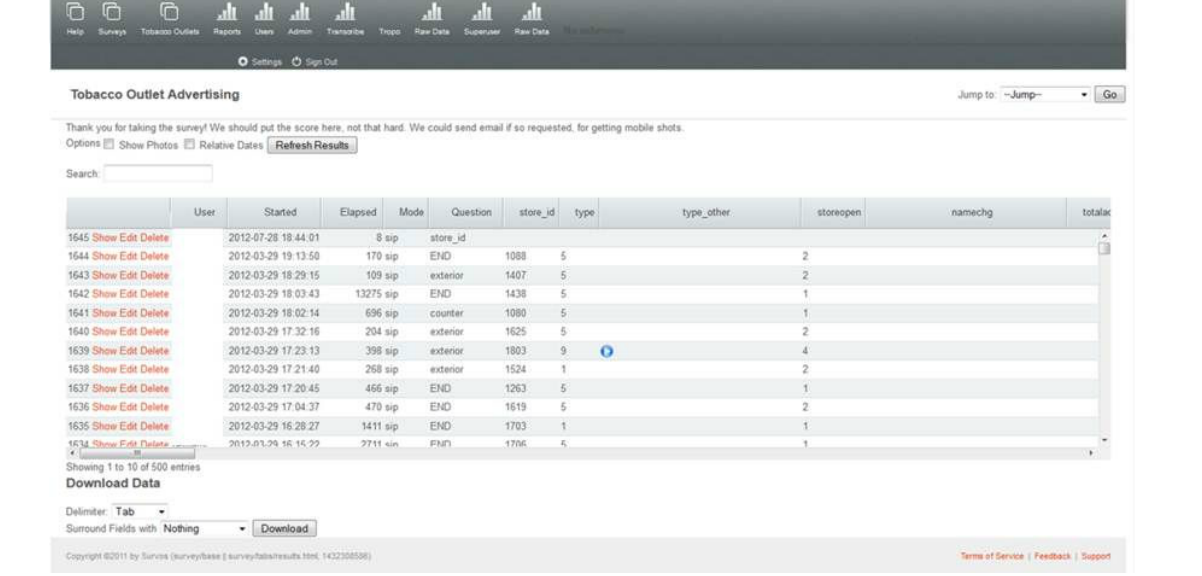
Figure 5. Back-End Database with Table of Individual Store Observations Updated in Real